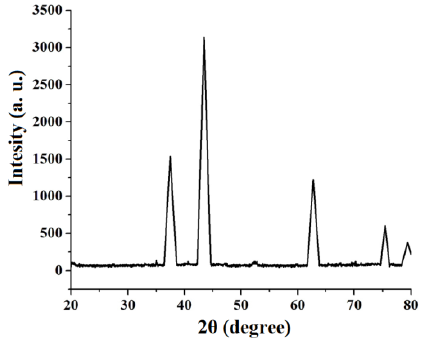
Figure 7. XRD patterns of NiO nanoparticles via complex thermal decomposed at 400 °C.